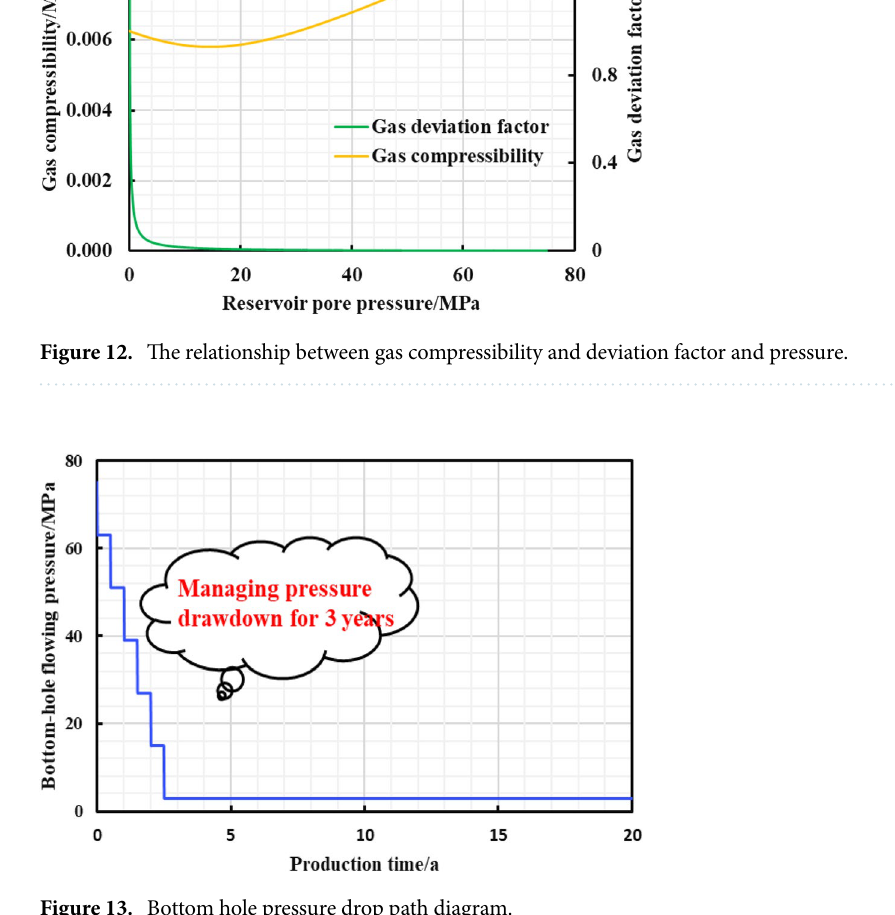
Figure 13. Bottom hole pressure drop path diagram.